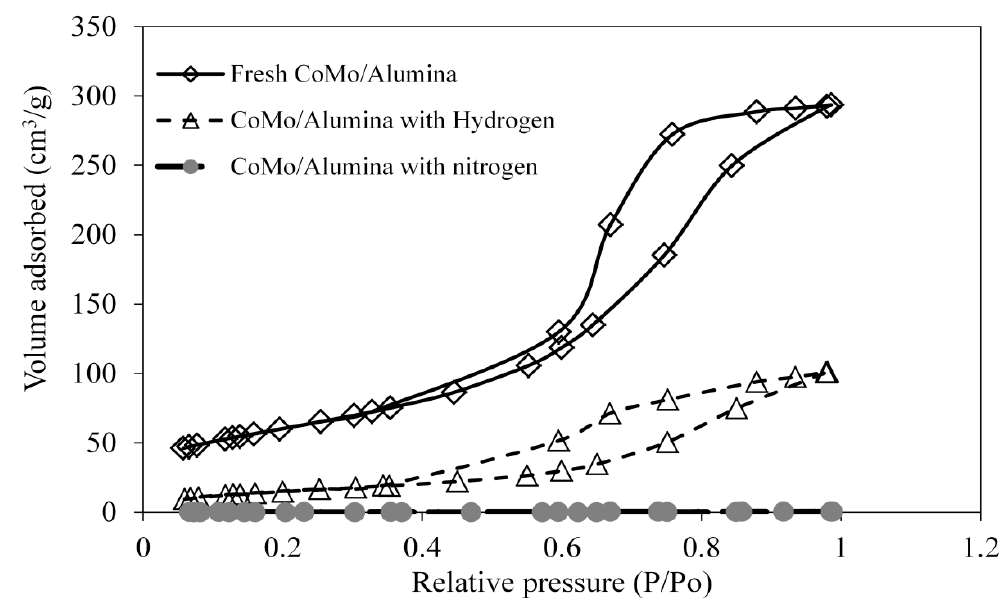
Figure 6. Nitrogen adsorption-desorption isotherm for the fresh and spent CoMo/Alumina after upgrading reaction under nitrogen and hydrogen environment.